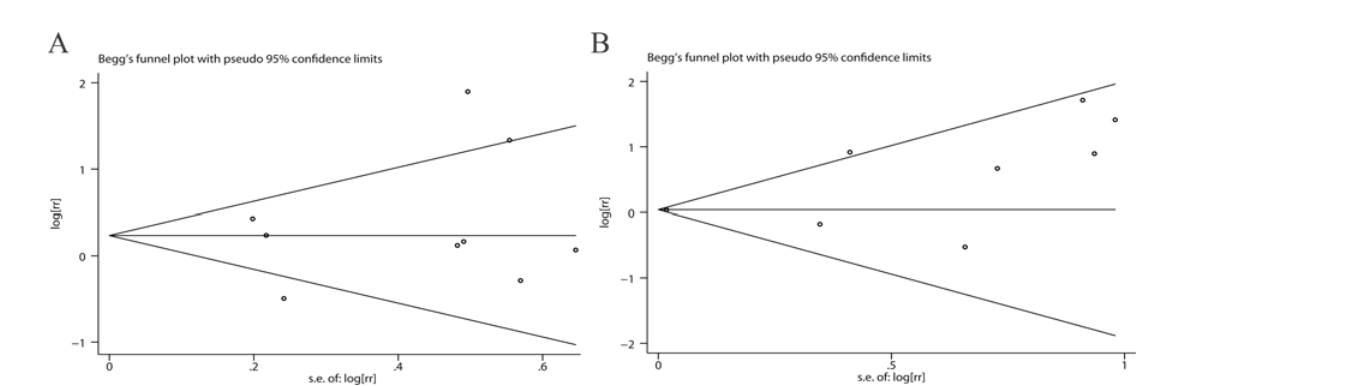
Fig 4. Funnel plots of p53 expression and RFS (A) or PFS